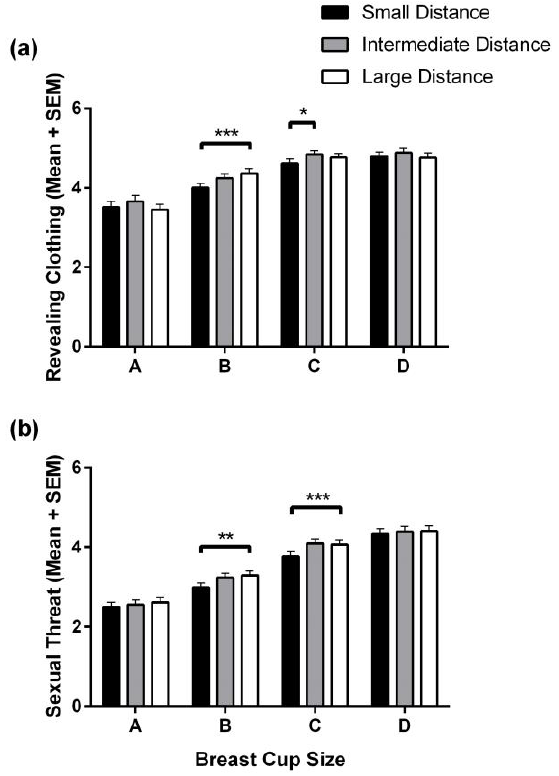
Figure 3. Women’s likelihood of ( a )wearing revealing clothing and ( b ) perceiving breasts as sexually threatening across breast sizes (A–D-cup) and intermammary distances. Note: p < 0.05 *, p < 0.01 **, p < 0.001 *** .